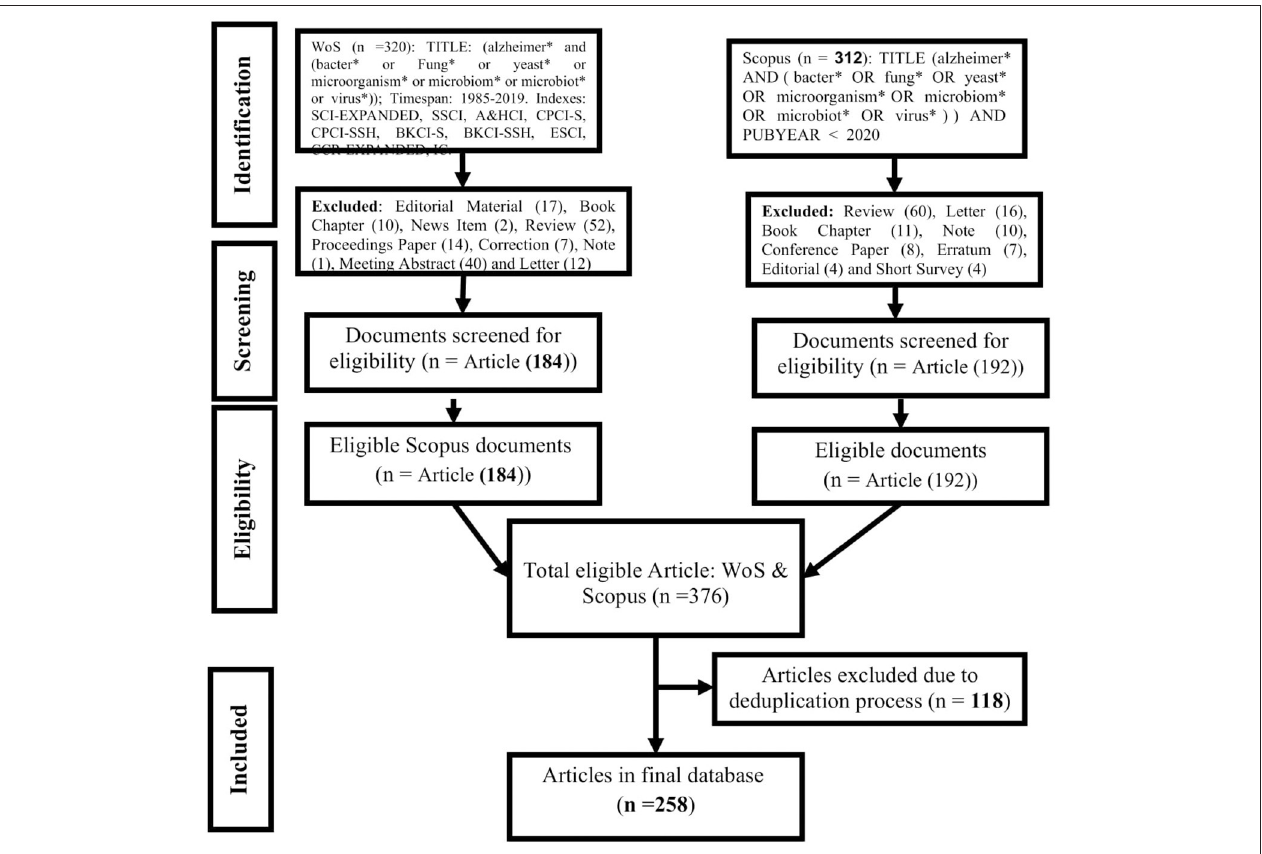
FIGURE 1 | Procedural course for mining, screening, and selecting documents for qualitative and quantitative synthesis of MPP-AD related